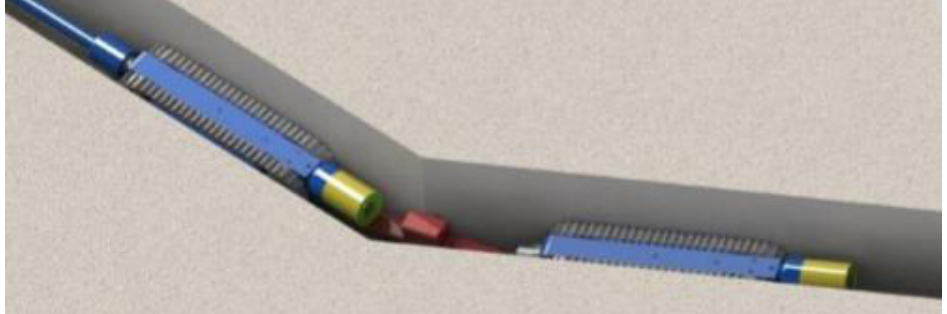
Figure 1. Conceptual design of a robot to move sensors through air slots. Three-unit design allows the robot to navigate bends. Cameras on crawler units are shown in yellow. The red unit between crawlers carries sensor and actuator. Reprinted from [11] with permission.